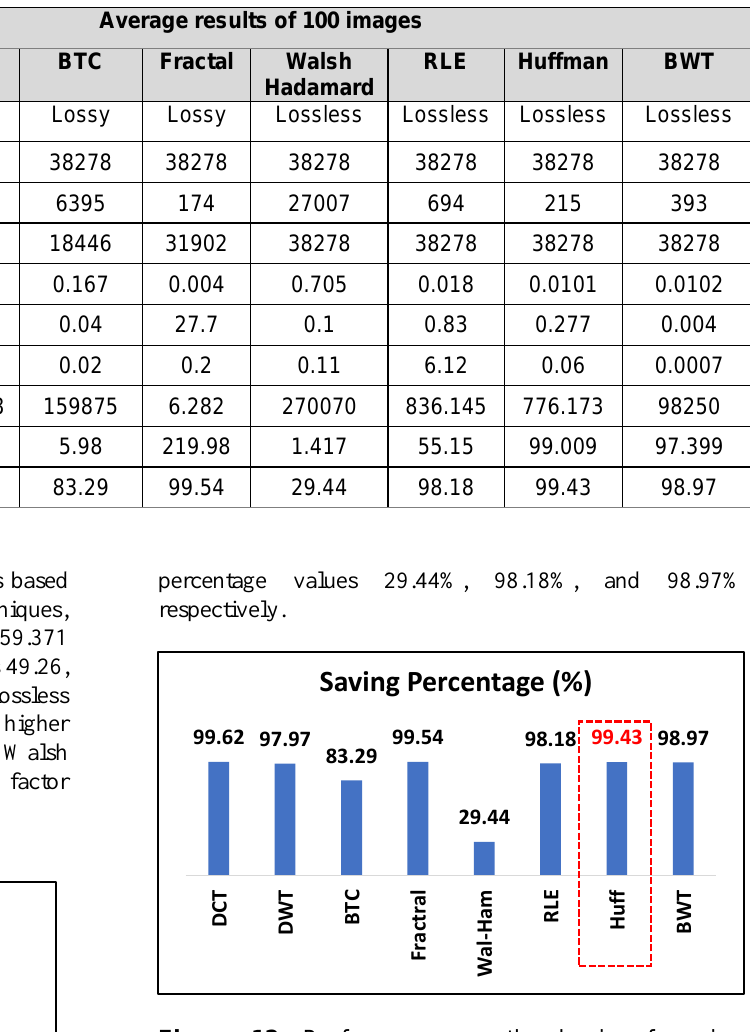
Figure 12. Performance on the basis of saving percentage offered by different image compression